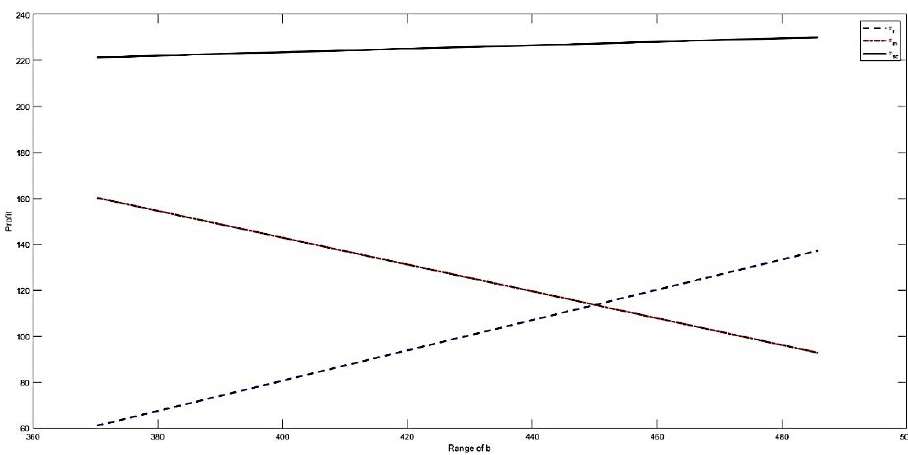
Fig. 6. The trend of variations of firms' profit after signing the contract in the range of contract b parameter.